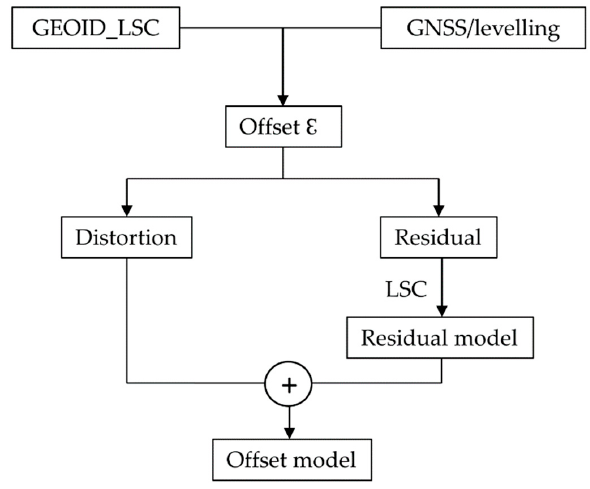
Figure 1. Schematic flow of offset model determination.